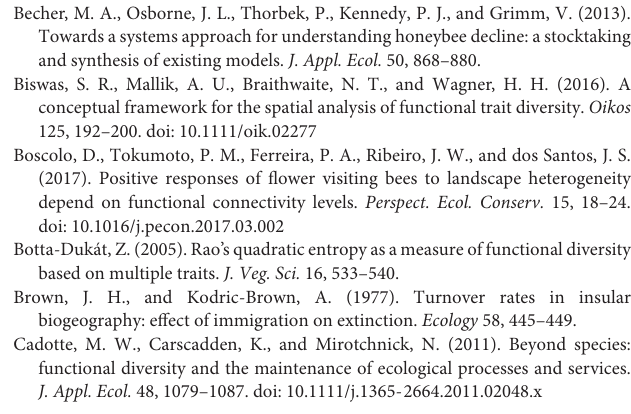
Supplementary Figure 1 | Scheme of a sampling unit hexagon and movement of the collectors during sampling; yellow circles represent the flagged polyethylene pipes used for marking the limits of the hexagons; arrows and numbers represent the trajectory and the sequence of motion, respectively, of the two collectors, who are identified by the colors red and blue; A–F: Sequence of movements conducted by the collectors during the sampling, covering all sides of the triangles that formed the hexagons. Extracted from Moreira et al. (2015). Supplementary Figure 2 | Scheme representing the collection with pan traps in a mosaic of agricultural and natural physiognomies, Chapada Diamantina, Bahia, Brazil. The vertices of the smaller triangles indicate the position of each pan trap. Central point sampling indicates the point of reference for choosing the points that represented the agricultural proportion gradient; landscape diversity and structural complexity (see text for details). Supplementary Figure 3 | General overview of the main conclusions of this study. Functional diversity is the result of filters operating at different spatial scales. Functional richness is benefited by the diversity of the landscape at the broad landscape level and less diverse landscapes at the proximal landscape level, which increases the volume occupied by the species in a multi-trait space. Functional divergence benefits from more diverse landscapes at the proximal landscape level and a lesser structural complexity of vegetation on the local scale. Finally, functional dispersion benefits from the structural complexity of the landscape at the broad landscape level and from a lower structural complexity to the proximal landscape level, which shifts the centroid from a multi-trait space to more extreme values of that space. Only the descriptors with the highest relative importance are